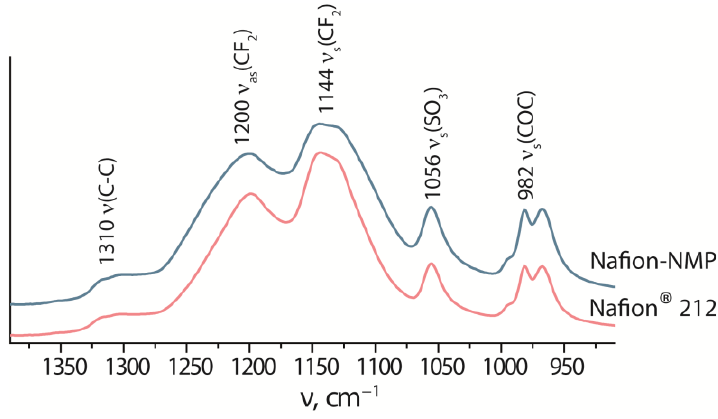
Figure 1. IR spectra of the dry Nafion ® 212 and Nafion-NMP membranes.